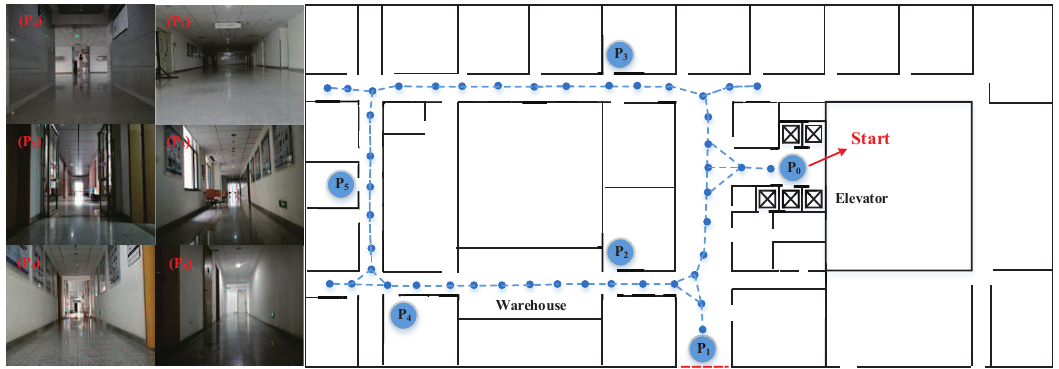
Figure 11. The topological navigation path of the robot.